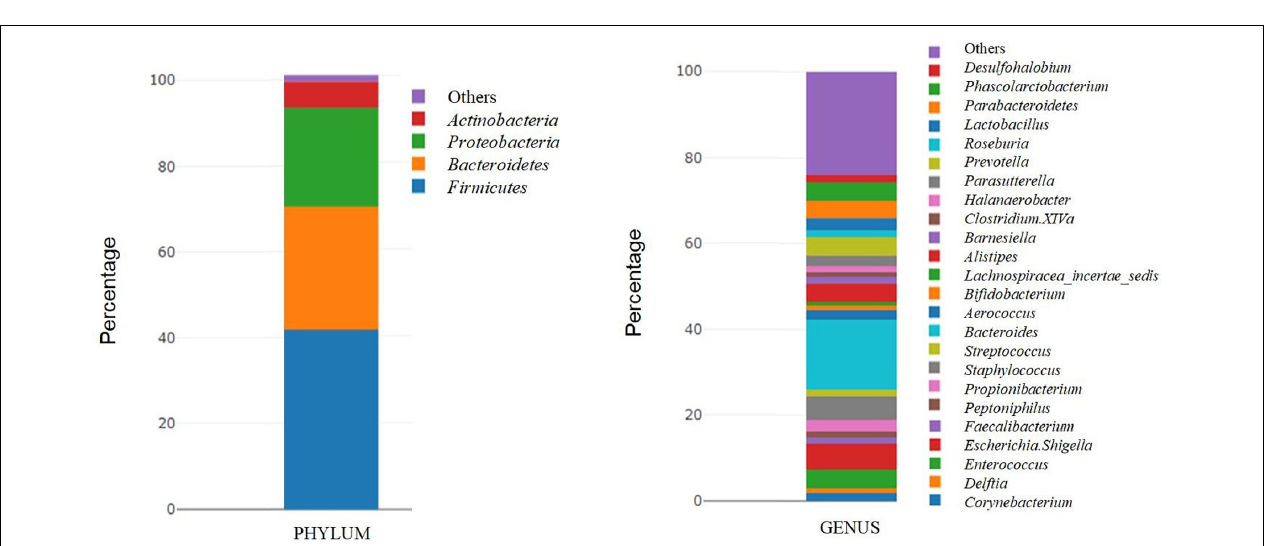
FIGURE 2 | Taxonomic microbial composition detected in tumor samples. Relative abundance of bacterial communities in tumor tissues ( n = 32) of bladdder cancer patientes are displayed at phylum level and genus level. Phyla and genera totaling < 1% of samples were assigned as “Others.”